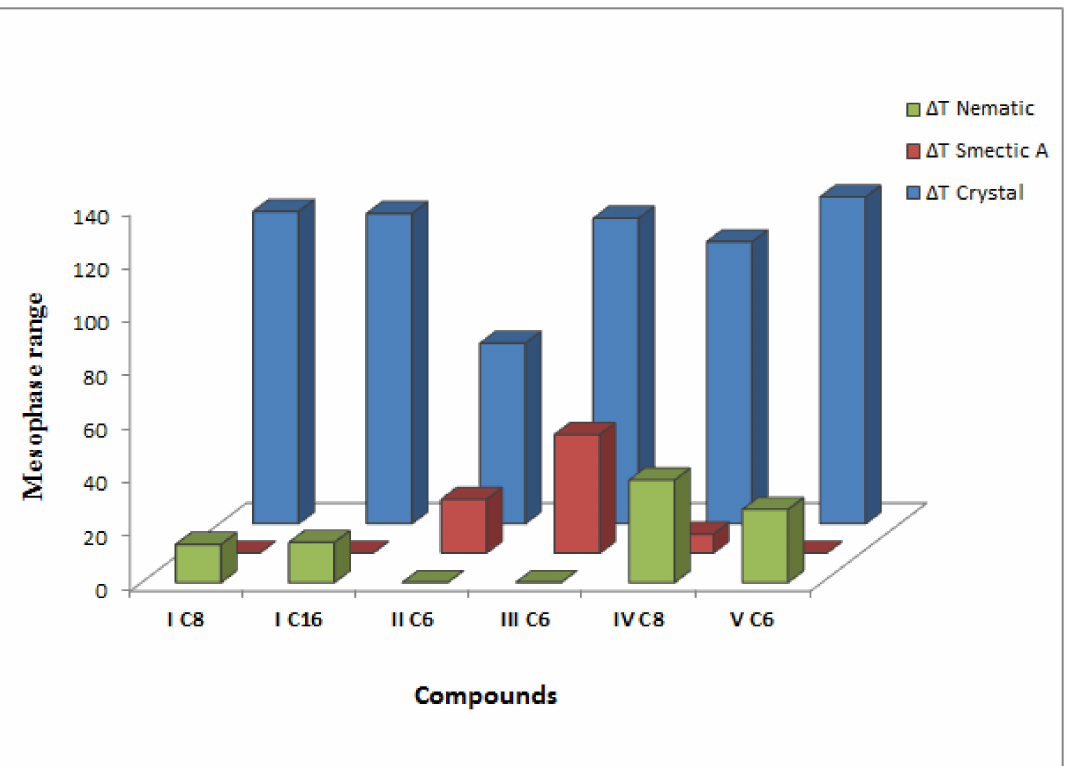
Figure 2. Mesophase ranges of compounds I C 8 , I C 16 , II C 6 , III C 6 , IV C 8 , and V C 6 .